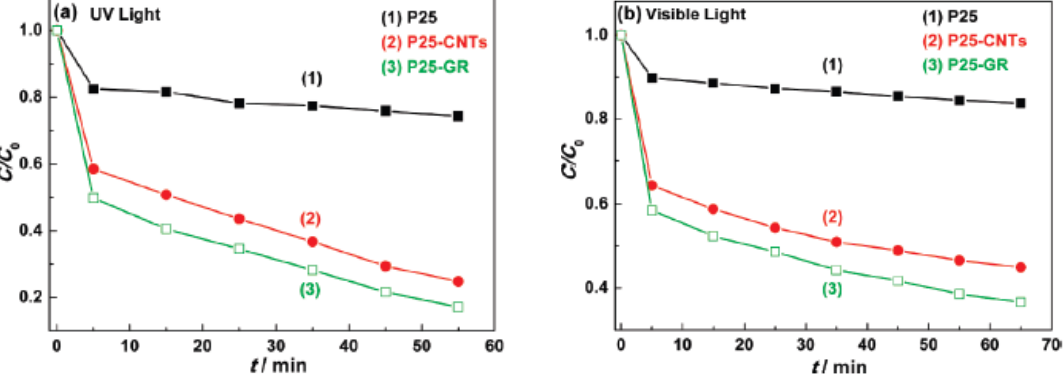
Figure 2. Photodegradation of malachite green (MB) under ( a ) UV light; and ( b ) Visible light ( λ > 400 nm) over (1) P25; (2) P25-CNTs; and (3) P25-GR photocatalysis respectively. Reprinted with copyright permission from reference [95]. Copyright © 2010, American Chemical